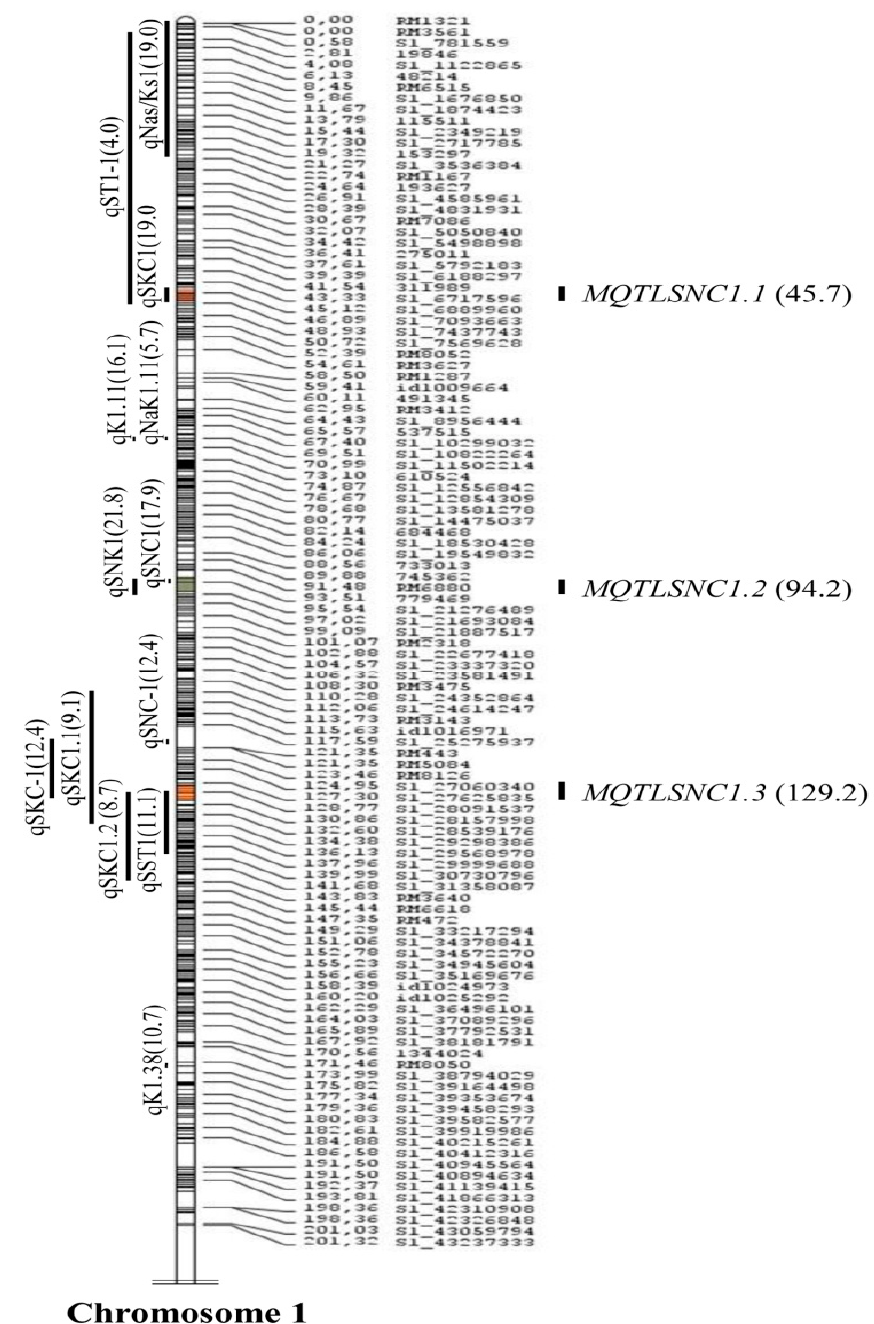
Figure 3. Meta-QTLs for shoot sodium concentration (SNC) in rice on chromosome 1. Vertical lines on the left of the chromosomes show the confidence interval of each QTL and values in parentheses indicate the percentage of phenotypic variation explained by these QTLs. Four meta-QTLs for SIS were shown on the right of the chromosomes, with the confidence interval indicated by vertical bars and the peak position of the meta-QTLs in cM on the consensus map (in parenthesis).